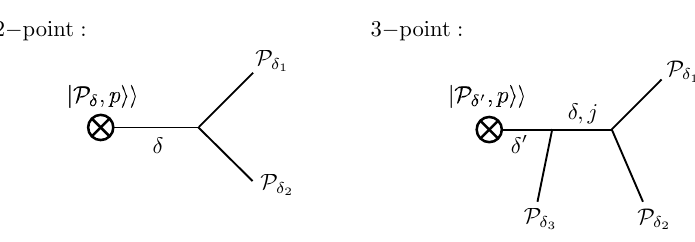
Figure 1 . Diagrams representing the two-point and three-point celestial blocks. Each vertex should be understood as an OPE differential operator C ijk in the CFT d − 2 . The symbol ⊗ represents the factor